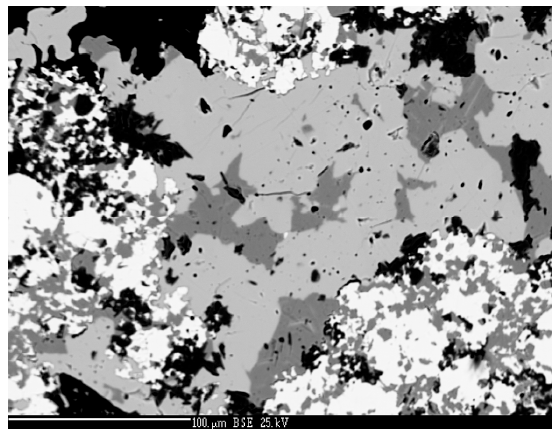
Figure 13. Berzelianite aggregates (dark grey) in Hg-hakite (light grey) in association with uraninite (white). BSE photo. P ř íbram, a dump of shaft 16. Photo J. Sejkora and P. Škácha.